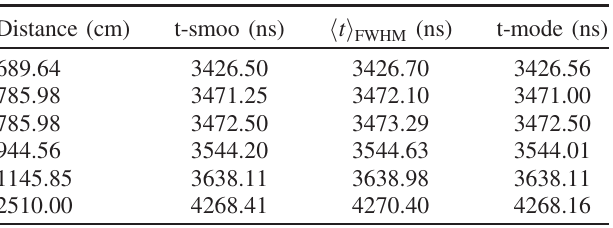
TABLE II. Raw-data arrival times at each nTOF detector distance L k in shot 2584 by the independent fiducial methods from the Appendix. The means h t i were calculated from the FWHM FWHM time regions of the recorded raw